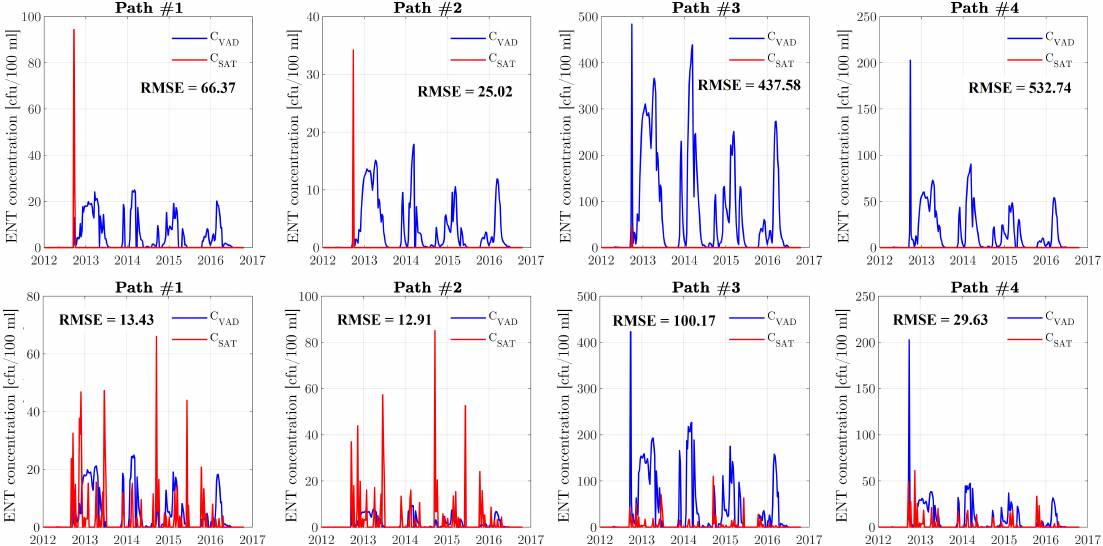
Figure 11. The C VAD and C SAT concentration diagrams for flow paths 1–4 towards Jezerce well (from Figure 6) for K = 0.2 m/s (top 4 diagrams) and K = 0.5 m/s (bottom 4 diagrams).